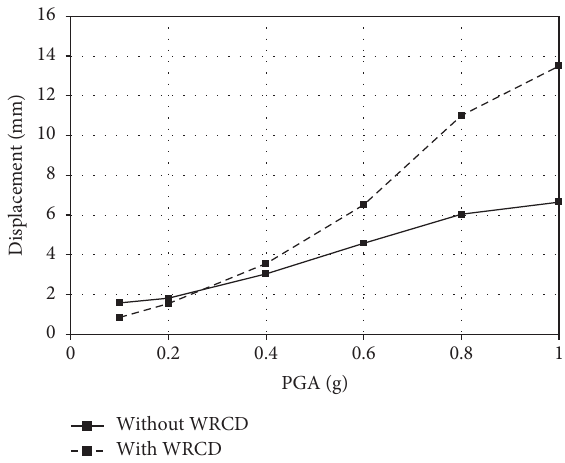
Figure 15: Te maximum displacement of 4# sliding pier top.